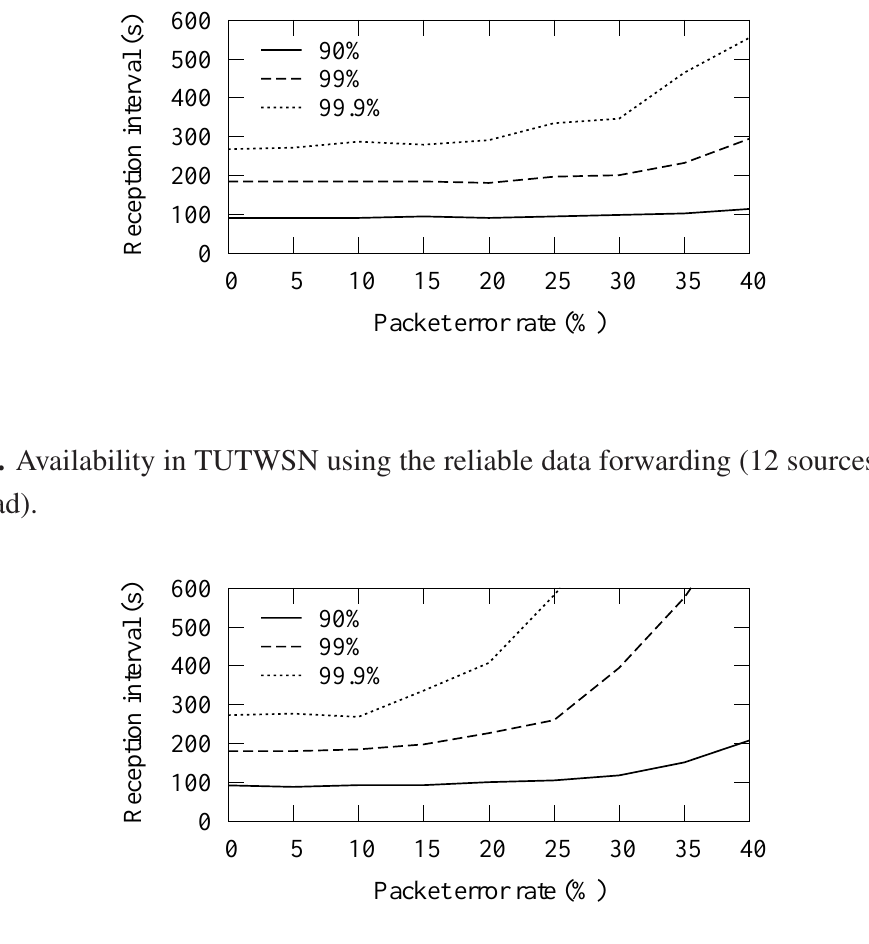
Figure 25. Availability in ZigBee using the reliable data forwarding (12 sources, 5.5 B/s offered load).